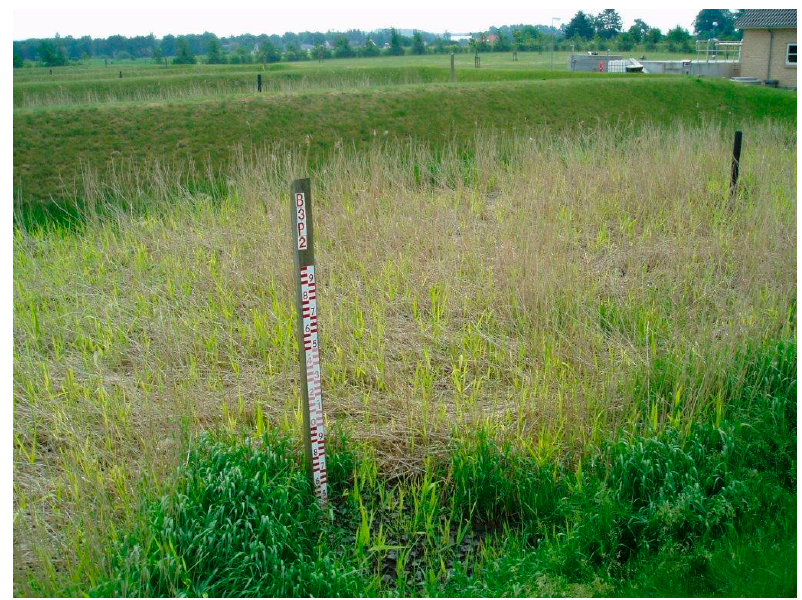
Figure 5. Yellow reeds and poor coverage in an STRB (Stenlille, Denmark) loaded with sludge rich in nickel (courtesy of Orbicon).